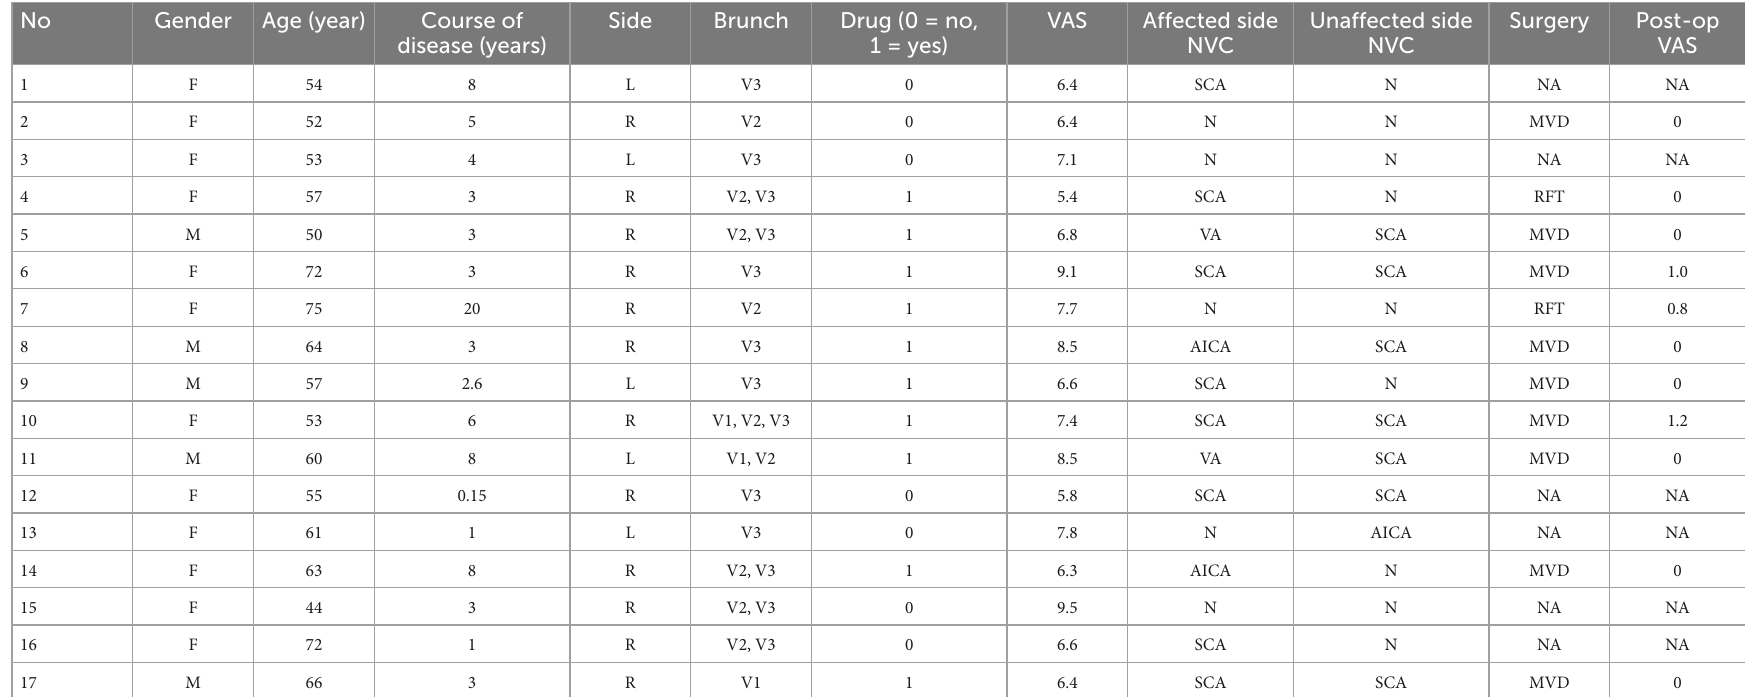
TABLE 1 Patients’ general information